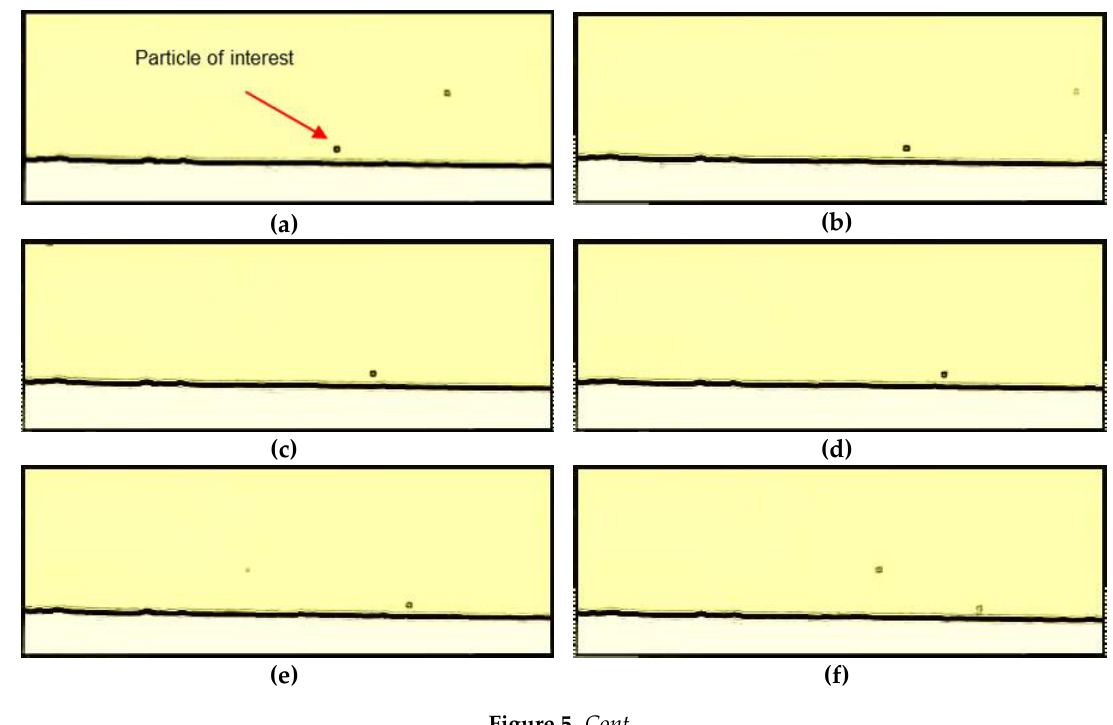
Figure 4. Tracked particles during filtration at different length coordinates along the membrane ( x coordinate) and height coordinate from the membrane ( y coordinate). The data in the figure is from filtration of lowly charged particles at 2 bar and crossflow velocity of 0.13 m/s and collected over 3 s filtration.